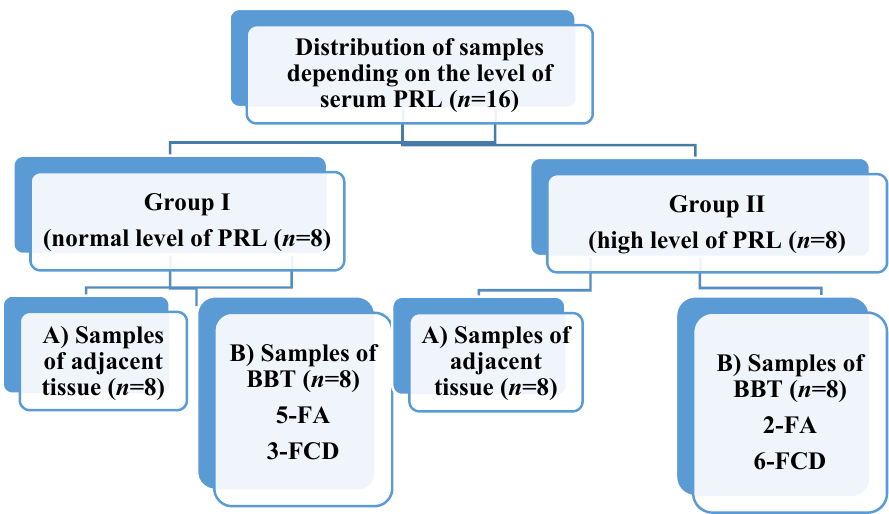
Figure 1. Distribution of breast tissue samples. PRL—prolactin, FA—fibroadenoma, FCD—fibrous cystic disease.